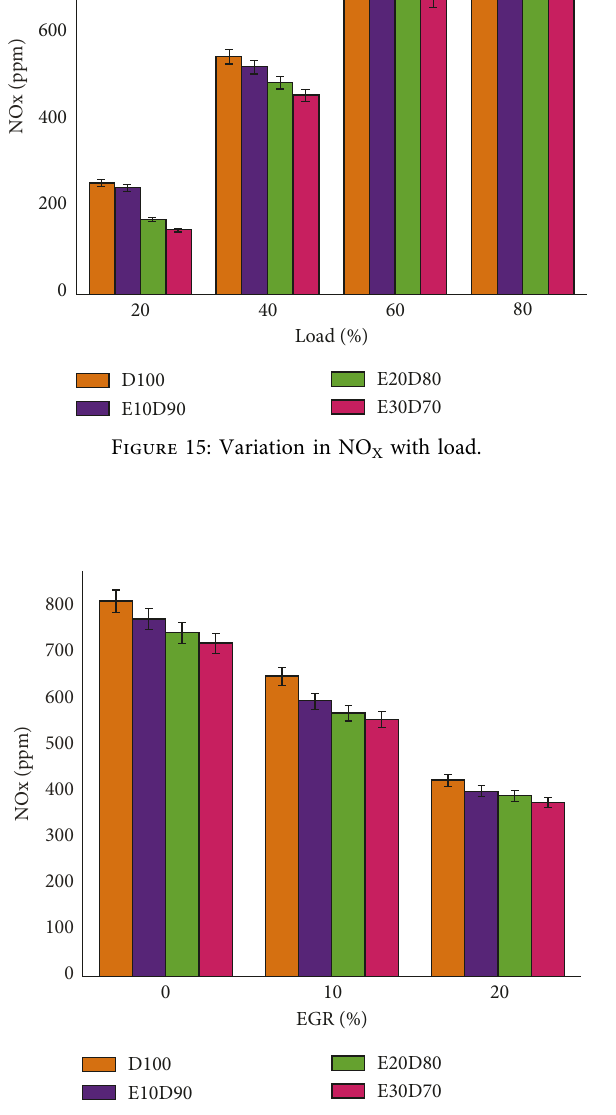
X with EGR (0%, 10%, and 20%) at 60%